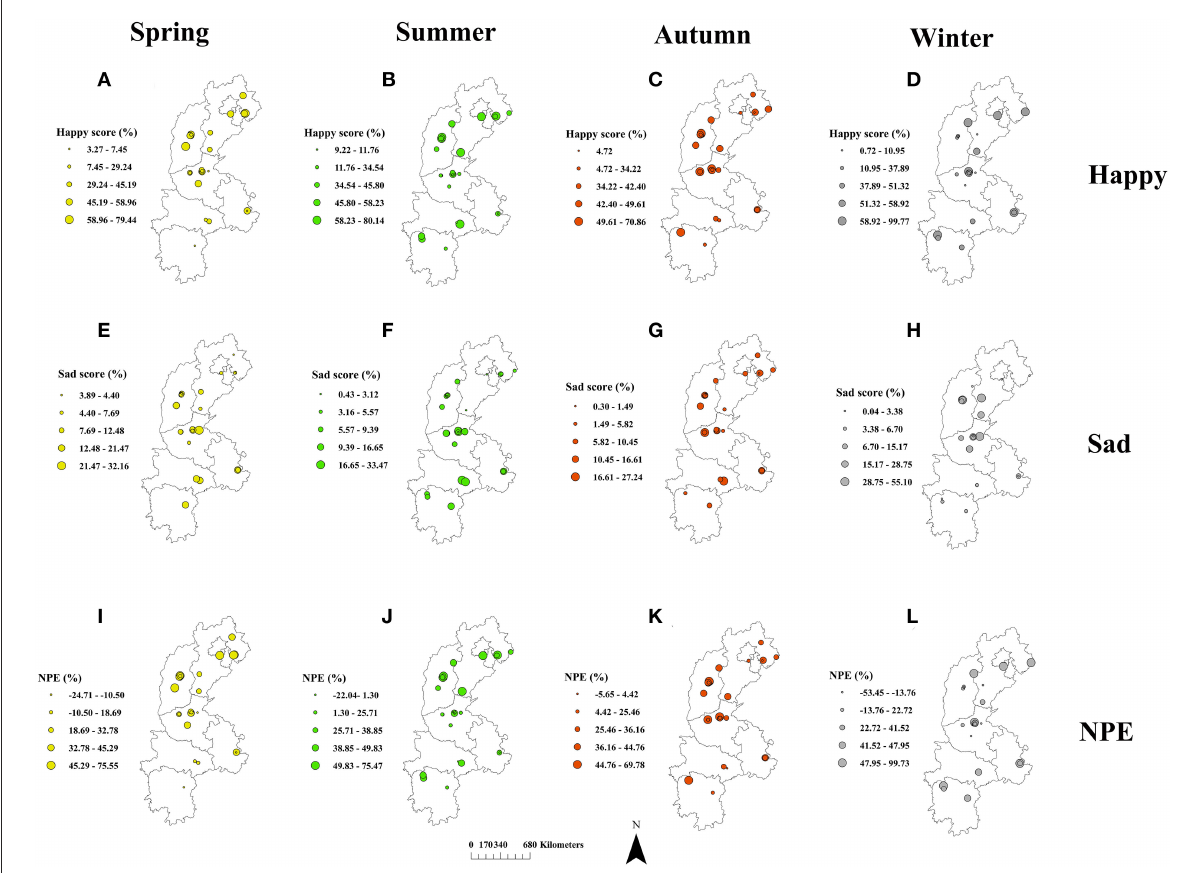
FIGURE3 Spatial distributions of facial expression scores (%) for happy (A–D) and sad (E–H) emotions and net positive emotion index (NPE) (I–L) of visitors in urban wetland parks in cities of Central China across four seasons of spring, summer, autumn, and winter of 2020.